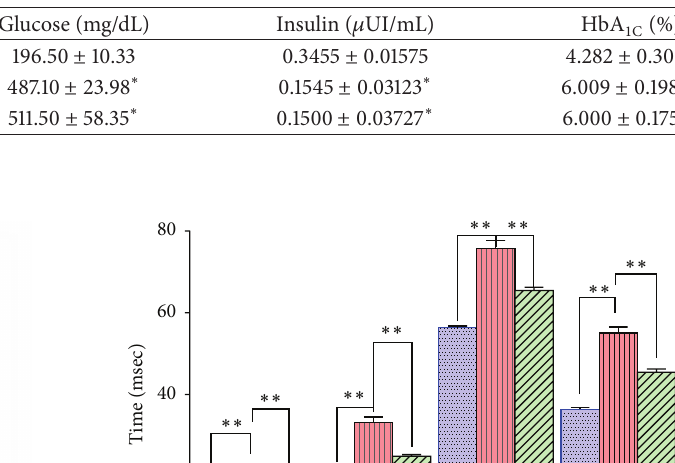
Table 2: Body weight and biochemical parameters of the rats after 90 days of treatment.